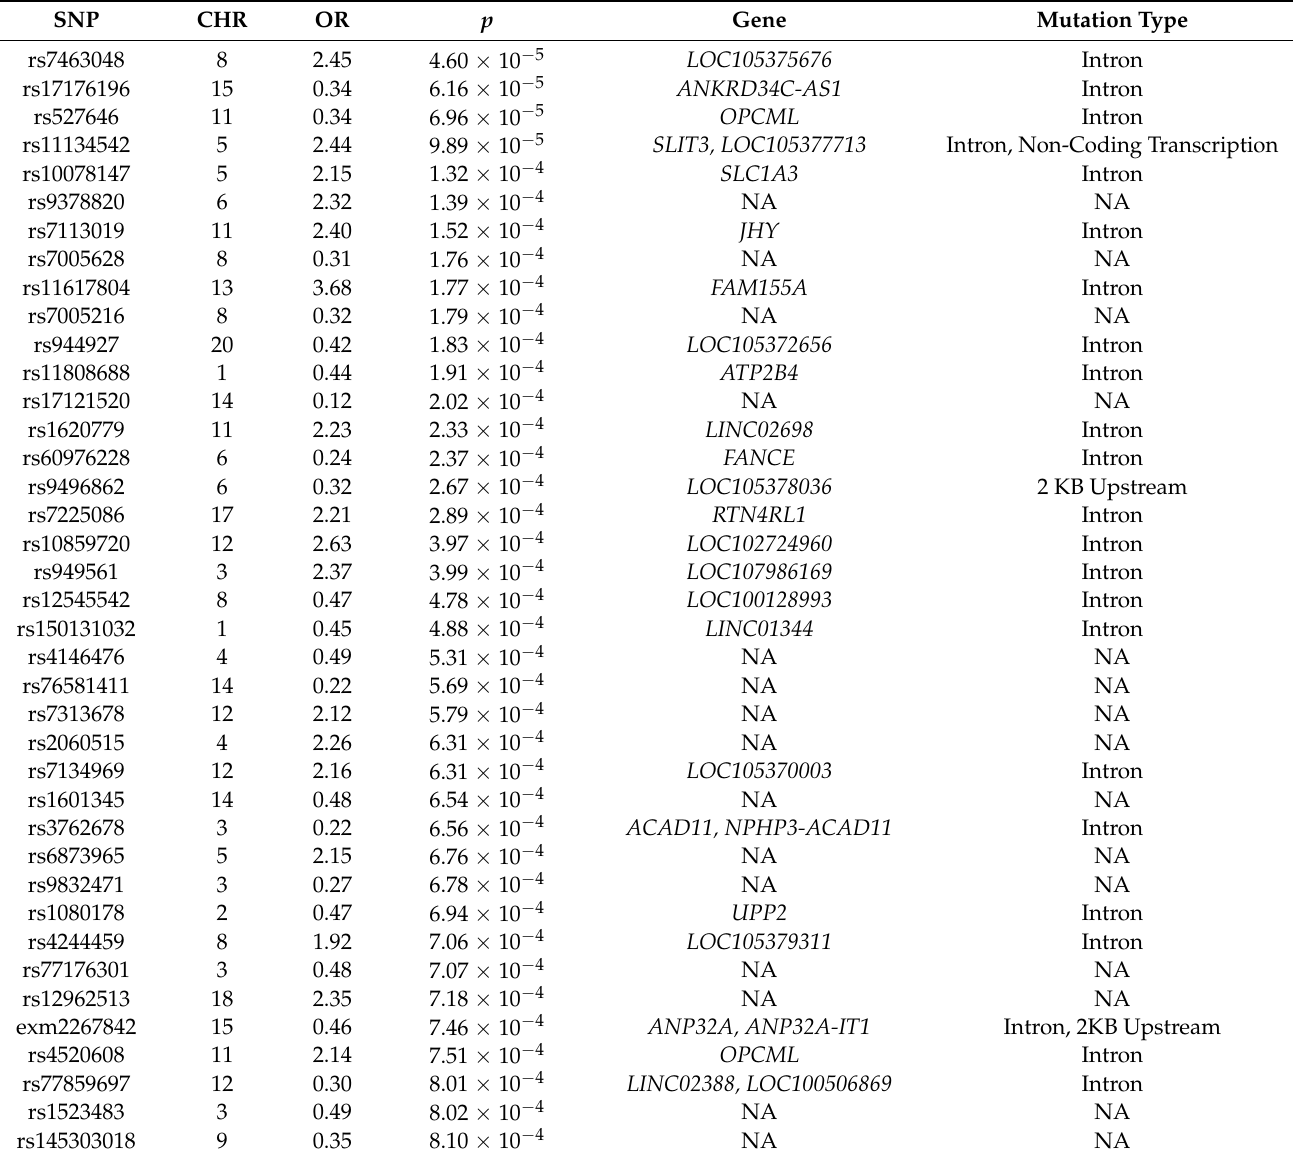
Table 2. The SNPs with p < 10 − 3 associated with platinum–based chemotherapy response in the discovery